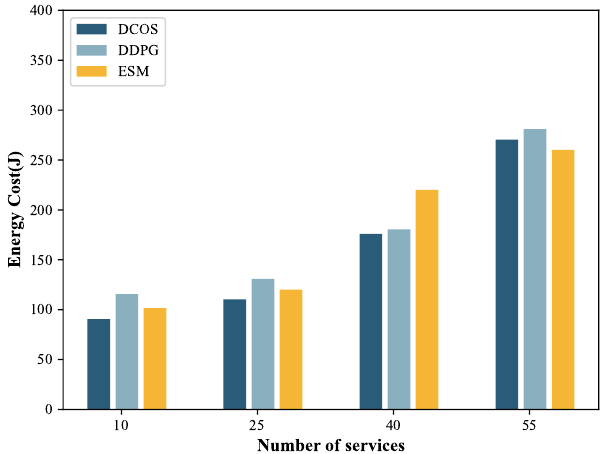
Figure 8. Comparison of energy consumption of different service